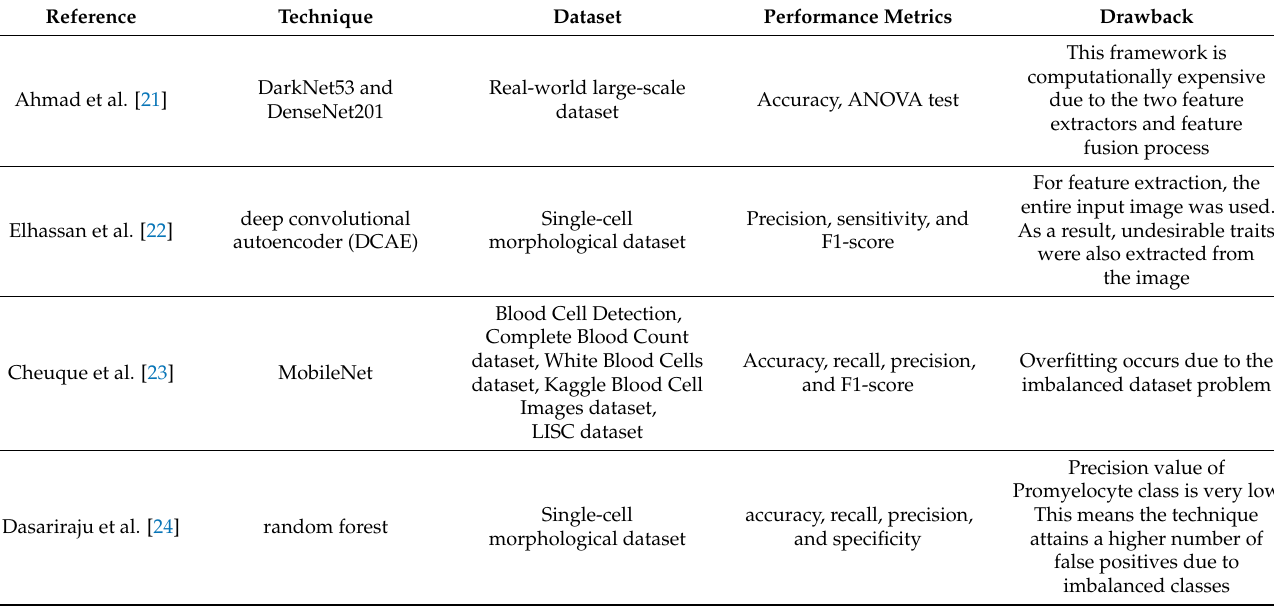
Table 1. Summary of literature